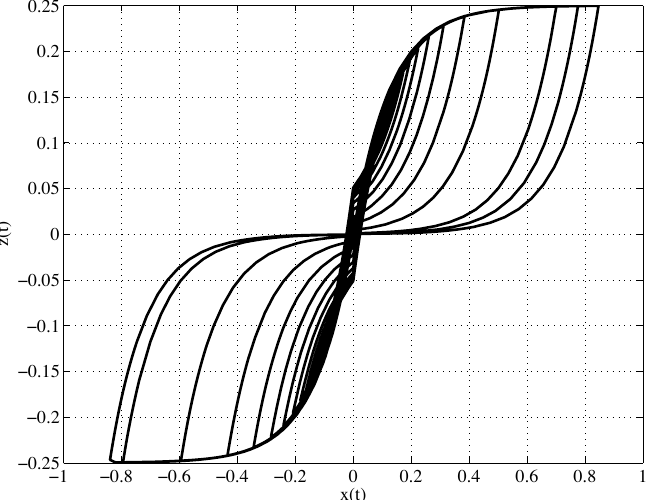
Figure 1. Simulation results. Plot of z ( t ) versus x ( t )